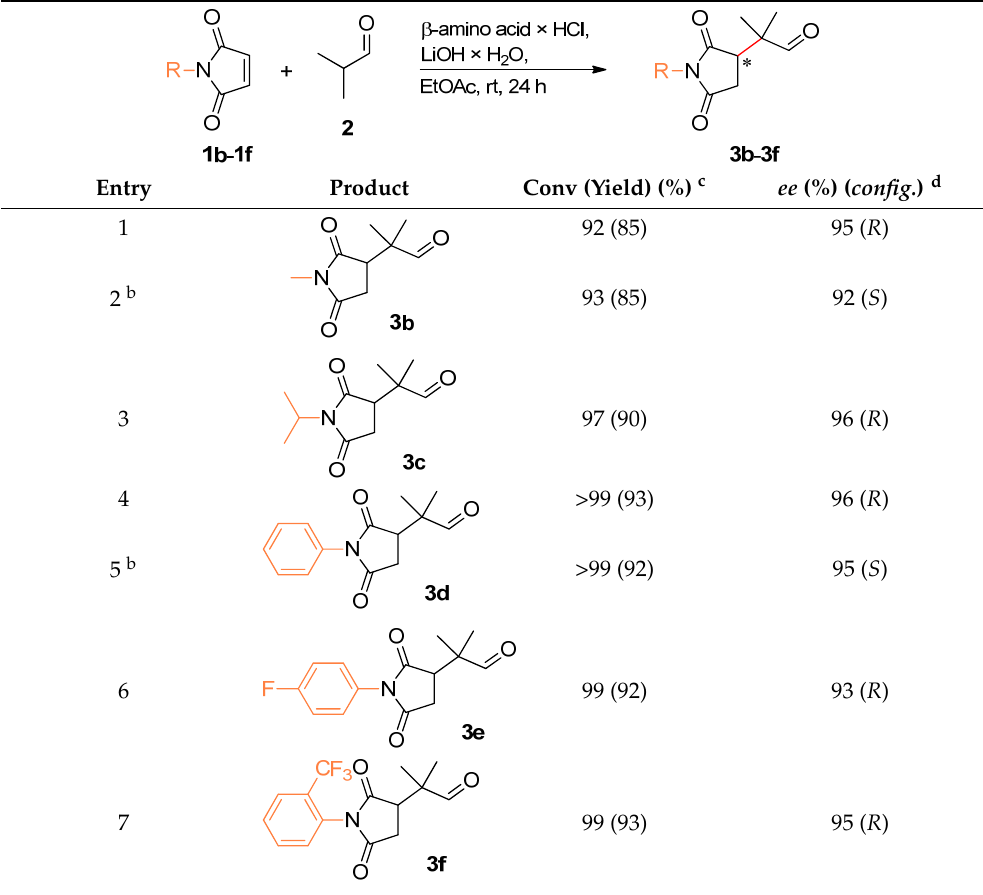
Table 4. Asymmetric Michael addition of 2 to N -substituted maleimides catalysed by β -amino acids 15 a or 14 b .